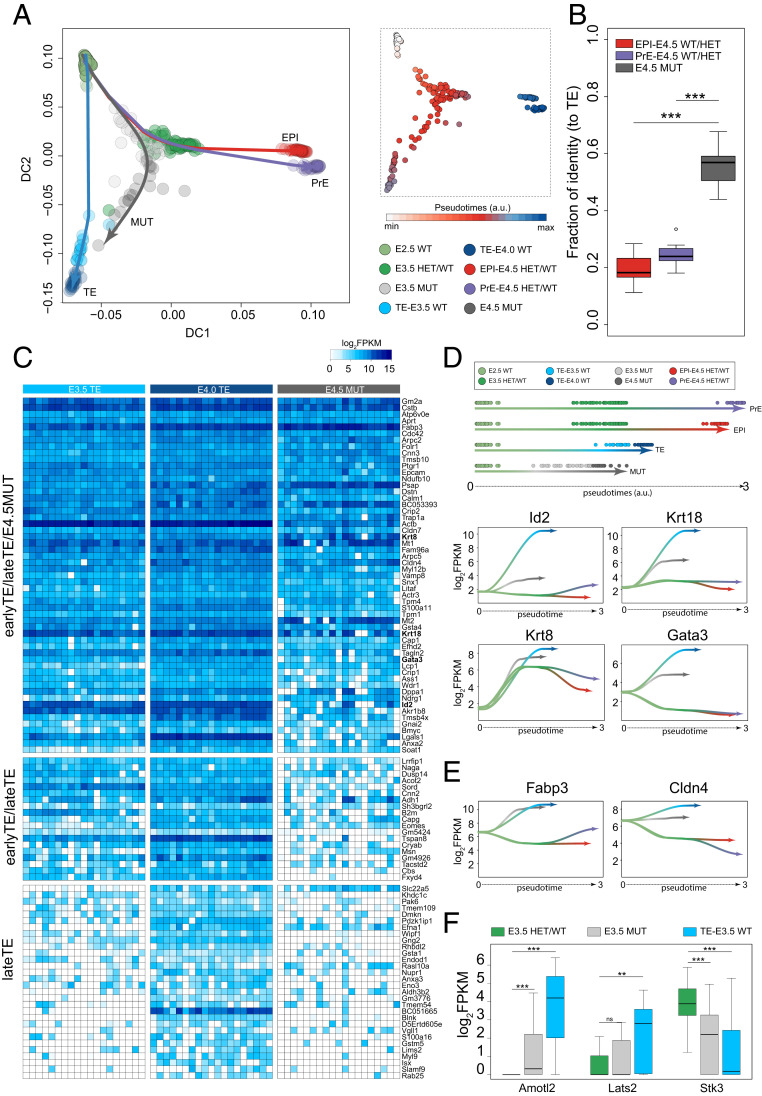
(A, Left) Diffusion component plot for E3.5/E4.5 WT/HET/MUT cells (this study) and E3.5 and E4.0 TE cells from ref. 63. Color represents the different genotypes/lineages. Trajectory lines were fitted with cubic line (lambda = 0.01). (A, Right) Diffusion component and pseudotime expression. (B) Fraction of similarities between E4.5 EPI (WT/HET)/E4.5 PrE (WT/HET)/E4.5 MUT and E4.0 TE cells computed using all expressed genes (log2FPKM > 0; Student’s t test, ***P < 0.001). (C) Heat map of TE markers identified by ref. 92 between ICM and TE single cells. (D) Identification of lineage trajectories and loess curve fitting between pseudotimes and log2FPKM for Id2, Krt18, Krt8, and Gata3. (E) Loess curve fitting between pseudotimes and log2FPKM for Fabp3 and Cldn4. (F) Box plot of FPKM expression of genes in Hippo signaling pathway (Student’s t test; *P < 0.05, **P < 0.01, ***P < 0.001).